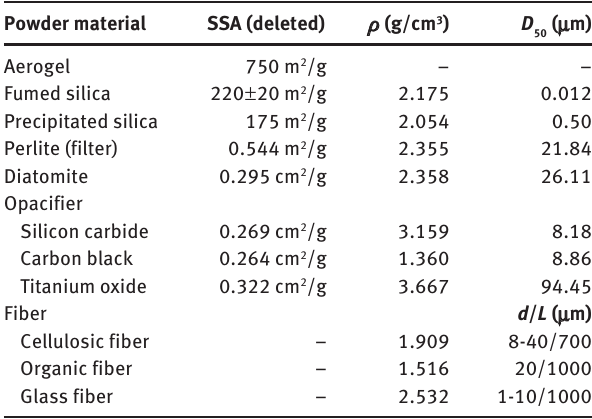
Table 5 Components of VIP samples and applied compressive load. Mix no.